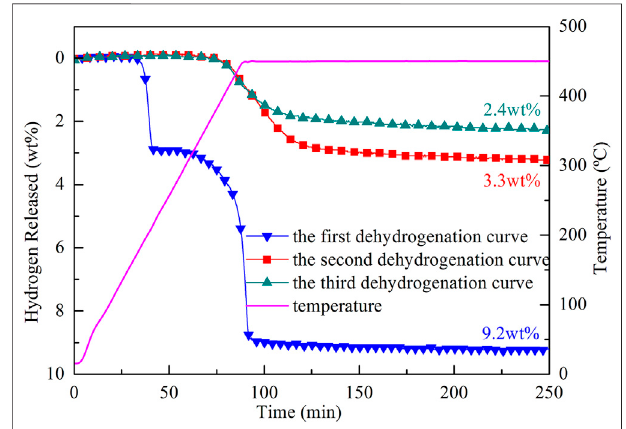
FIGURE 6 | Cyclic dehydrogenation curves of the 2LiBH 4 – Li 3 AlH 6 composite.